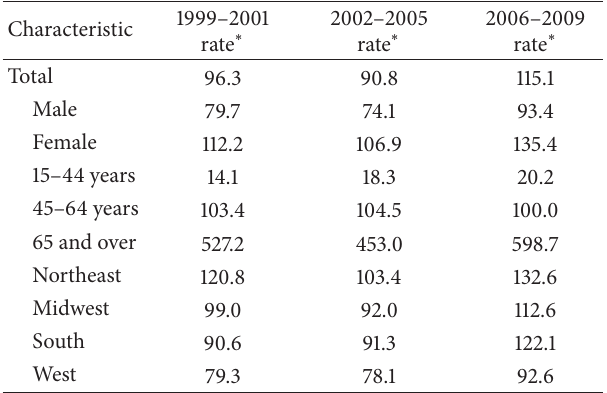
Table 2: Estimated rate ∗ of pulmonary hypertension † all-listed diagnoses during hospital stay, by selected characteristics and period: National Hospital Discharge Survey, United States, 1999–